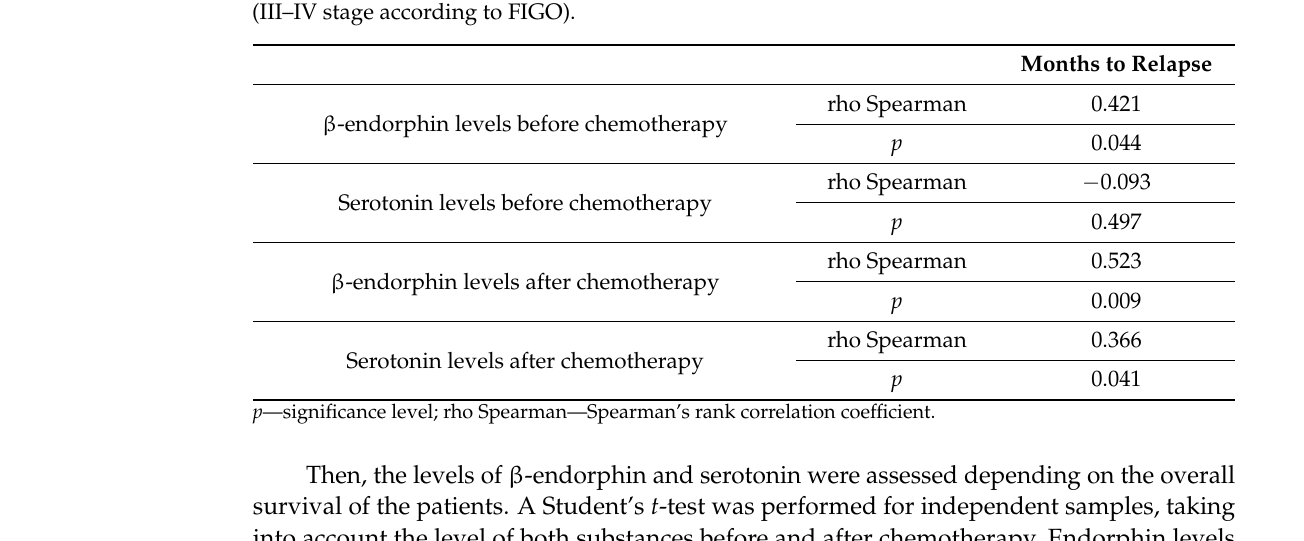
Table 9. Relationship of β -endorphin, serotonin, and PFS levels in the group- with ovarian cancer (III–IV stage according to FIGO).